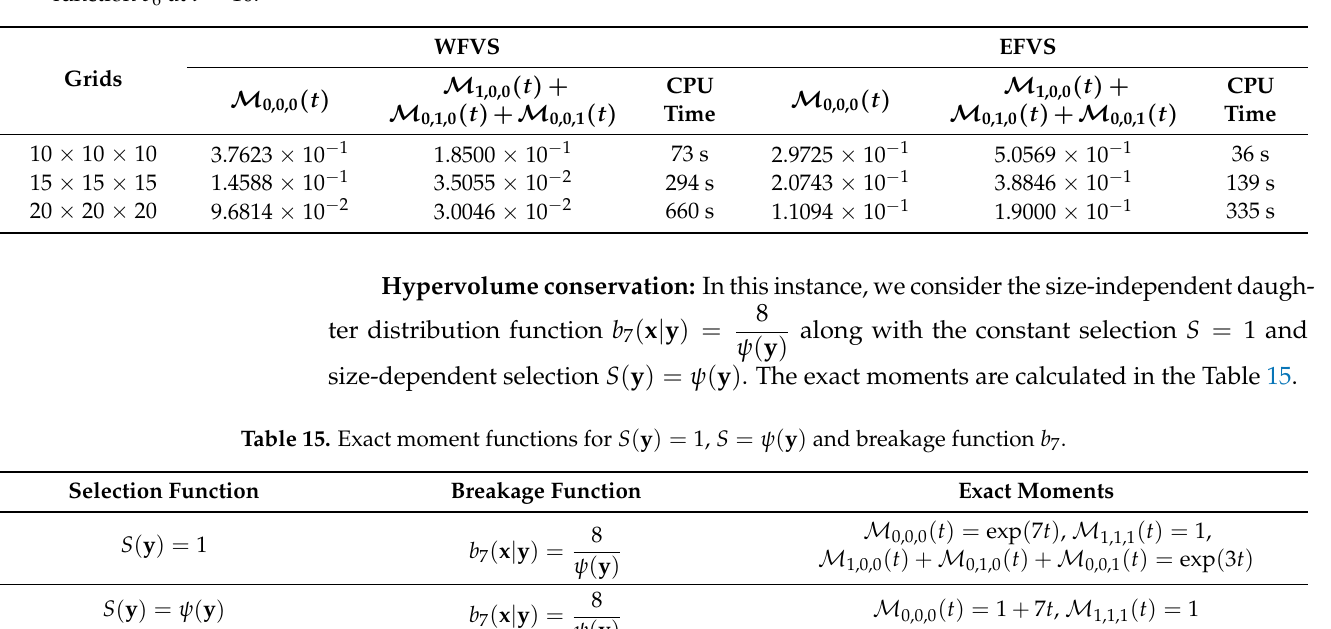
Table 14. Relative error for the weighted moments at different grid points for the test case with S = φ ( x ) and breakage function b 6 at t = 10.